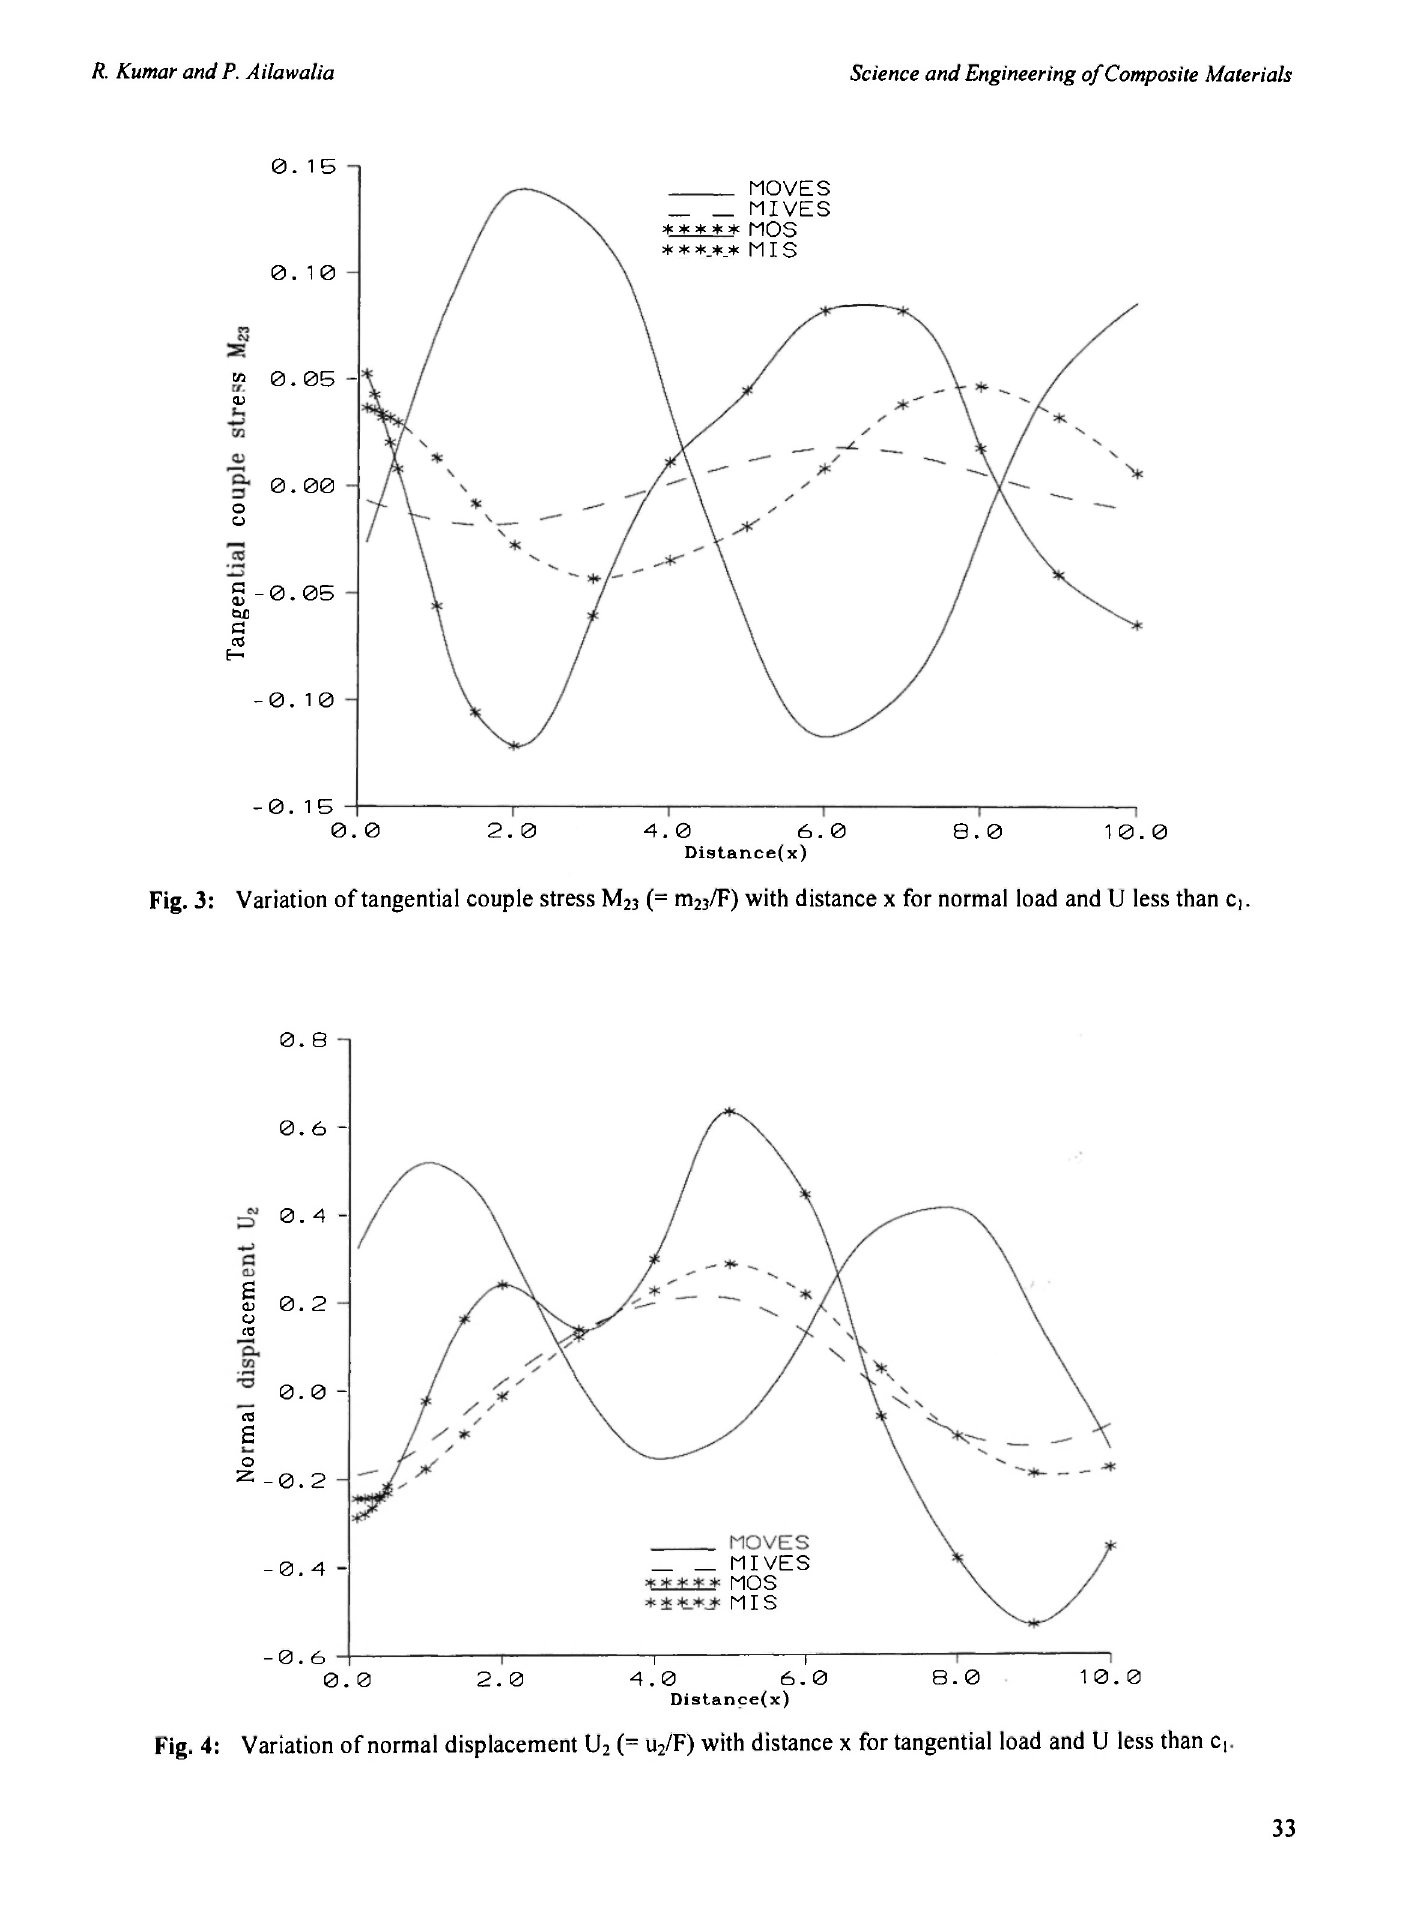
Fig. 4: Variation of normal displacement U 2 (= u 2 /F) with distance χ for tangential load and U less than